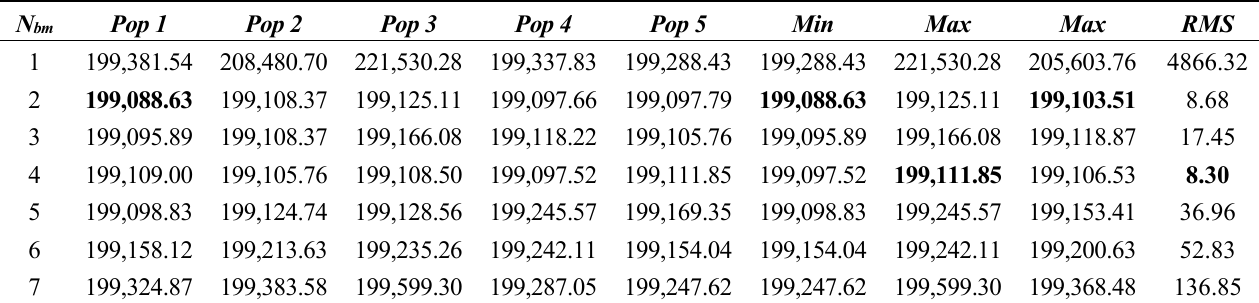
Table 1. World Bank (1991) [61] case study. Optimal results for the case WB-1. N bm